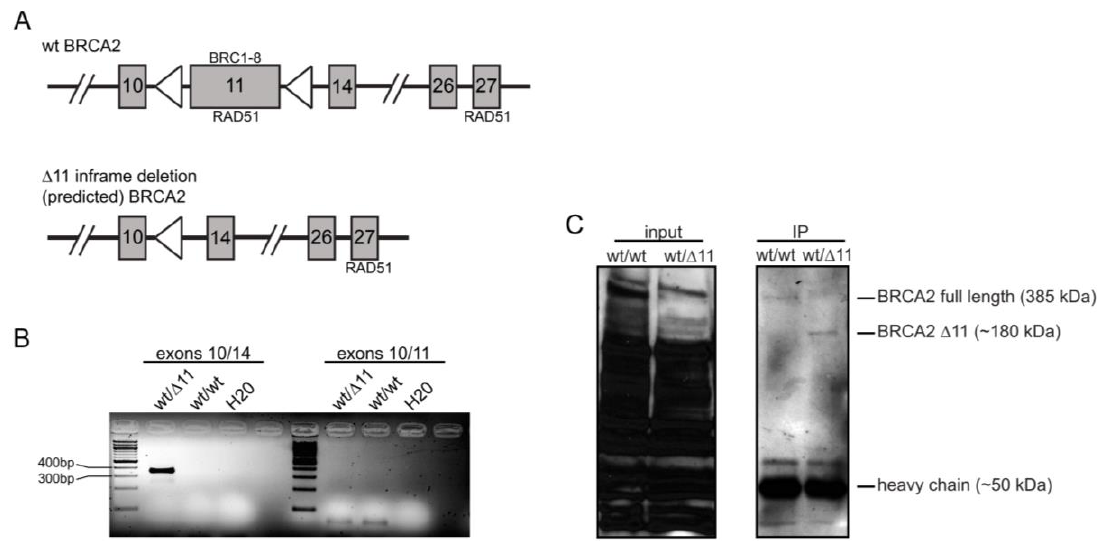
Figure 1. Brca2 delta 11 isoform. ( A ). Schematic of mouse wild-type (wt) Brca2 and Brca2 delta 11 deletion following Cre activity. Hatched lines represent excluded genomic regions and triangles (loxP sites). RAD51 interacts with BRCA2 at two distinct domains (i.e., the BRC repeats located in exon 11 and the c-terminal region of BRCA2) as noted. ( B ). PCR amplification of cDNA from BRCA2 wild-type and delta 11 isoform mouse testis for products encompassing exons 10 and 14 (362 bp product) and exons 10 and 11 (67 bp product). ( C ). Western blot depicting full-length BRCA2 and delta 11 deletion isoform protein products immunoprecipitated from mouse testis whole-cell lysates (original full Western Blot image provided in Figure S1).